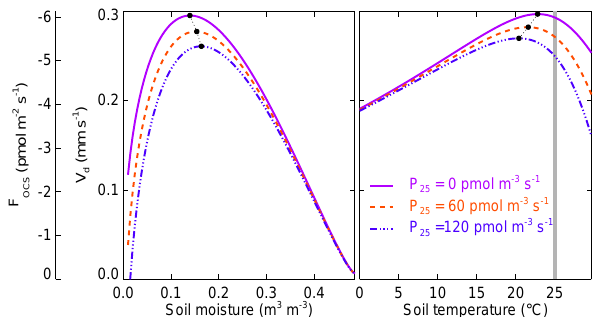
Figure 7. Sensitivity of the modelled OCS flux ( F OCS ) and depo- sition velocity ( V d ) to soil OCS emission rate. The soil moisture and temperature response curves shown here were obtained using the diffusivity model of Moldrup et al. (2003) and assuming a CA enhancement factor of 30000, a soil pH of 7.2 and a soil depth of 1m. OCS source is assumed to occur only in the top 5cm. Closed circles indicate the temperature or soil moisture optimum of each response curve and the grey thick line in the right panel indicates the set optimal temperature for CA activity (25 ◦ C in this